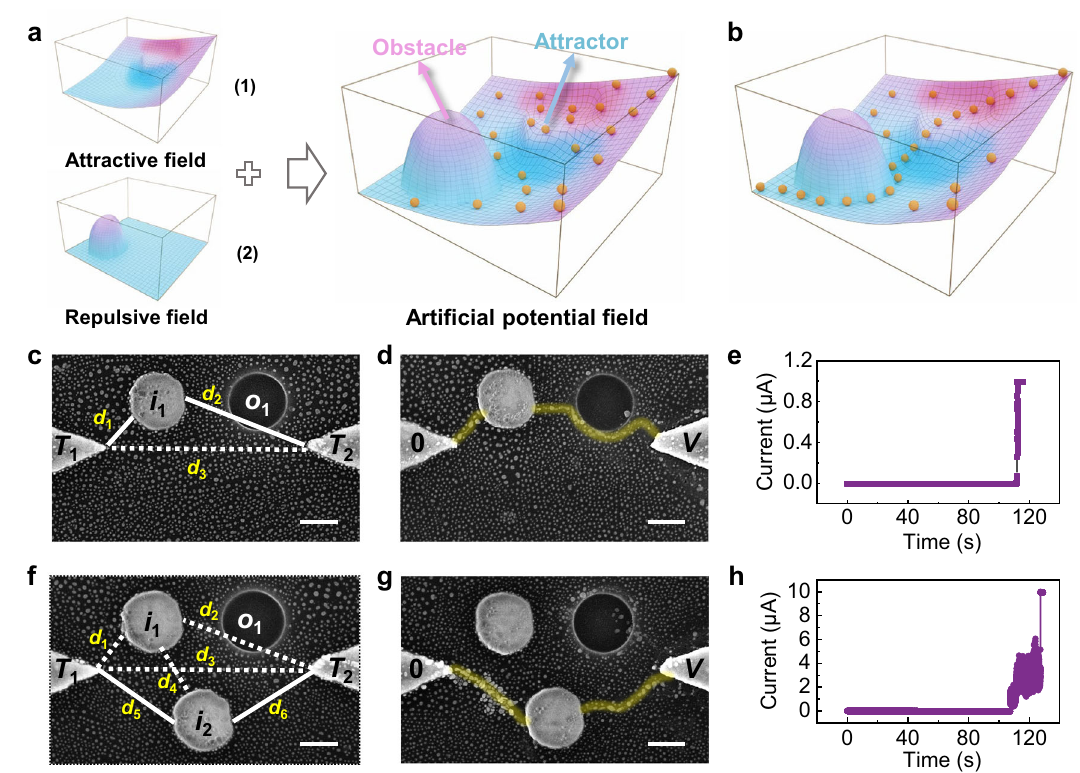
Fig. 4 | Arti fi cial potential fi eld with superimposed attractive and repulsive components. a Schematic illustration of an arti fi cial potential fi eld superimposed by the (1) attractive fi eld and(2) repulsive fi eld. b Schematic illustration of the fi nal optimal route composed of Ag nanoclusters based on the gradient descent. c SEM image of the devicewith anattractor i 1 and anobstacle o 1 betweenthe terminals T 1 and T 2 .Theshortestpathisaccordinglymarkedwithasolidline.Scalebar:200nm. d SEM image of the connection path in ( c ) under the voltage bias V . Ag clusters adaptively avoid the obstacle o 1 to align into a connective fi lament along the ori- ginalshortestpath.Theappliedvoltagebias V was40V.Scalebar:200nm. e Time-